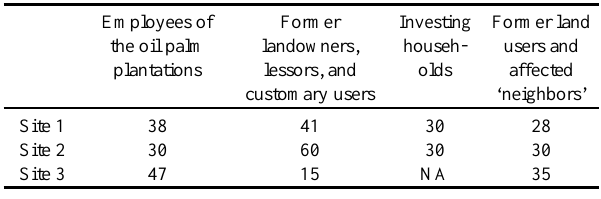
Table 3 . Number of respondents of each